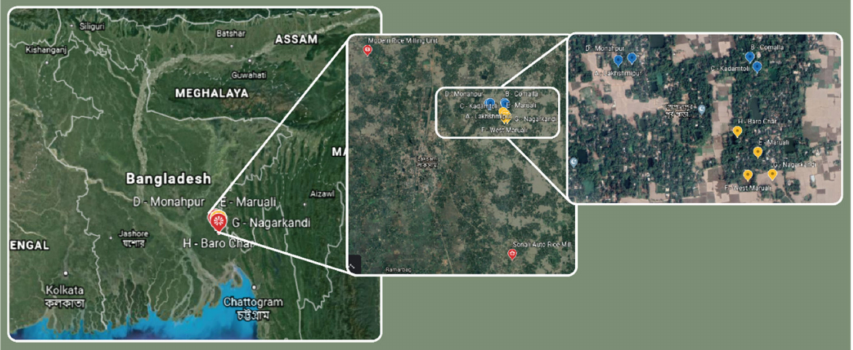
Figure 1. Map showing locations of the participating mills and the villages in Bangladesh, based on GPS coordinates. Villages A–D are marked yellow, E-H blue, and the mills are marked red.